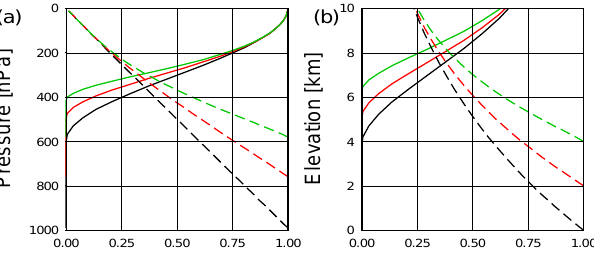
Figure 1. λ σ (σ) (solid lines) and σ (dashed lines) as a function of (a) pressure and (b) elevation for a location at 0 (black lines), 2000 (red lines) and 4000 (green lines) ma . s . l . , respectively.